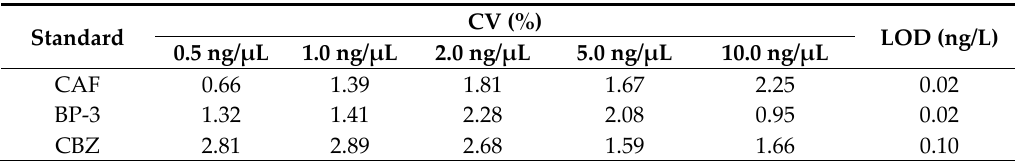
Table 4. Coefficient of Variation (CV) for five concentration levels of tested micropollutants and the Limit of Detection (LOD).